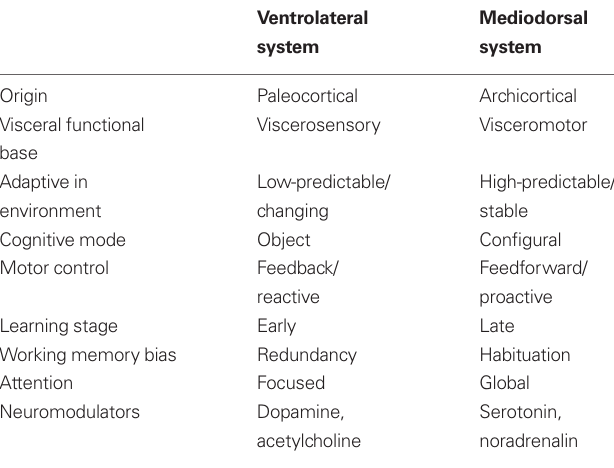
Table 1 | Characteristics of the ventrolateral and mediodorsal